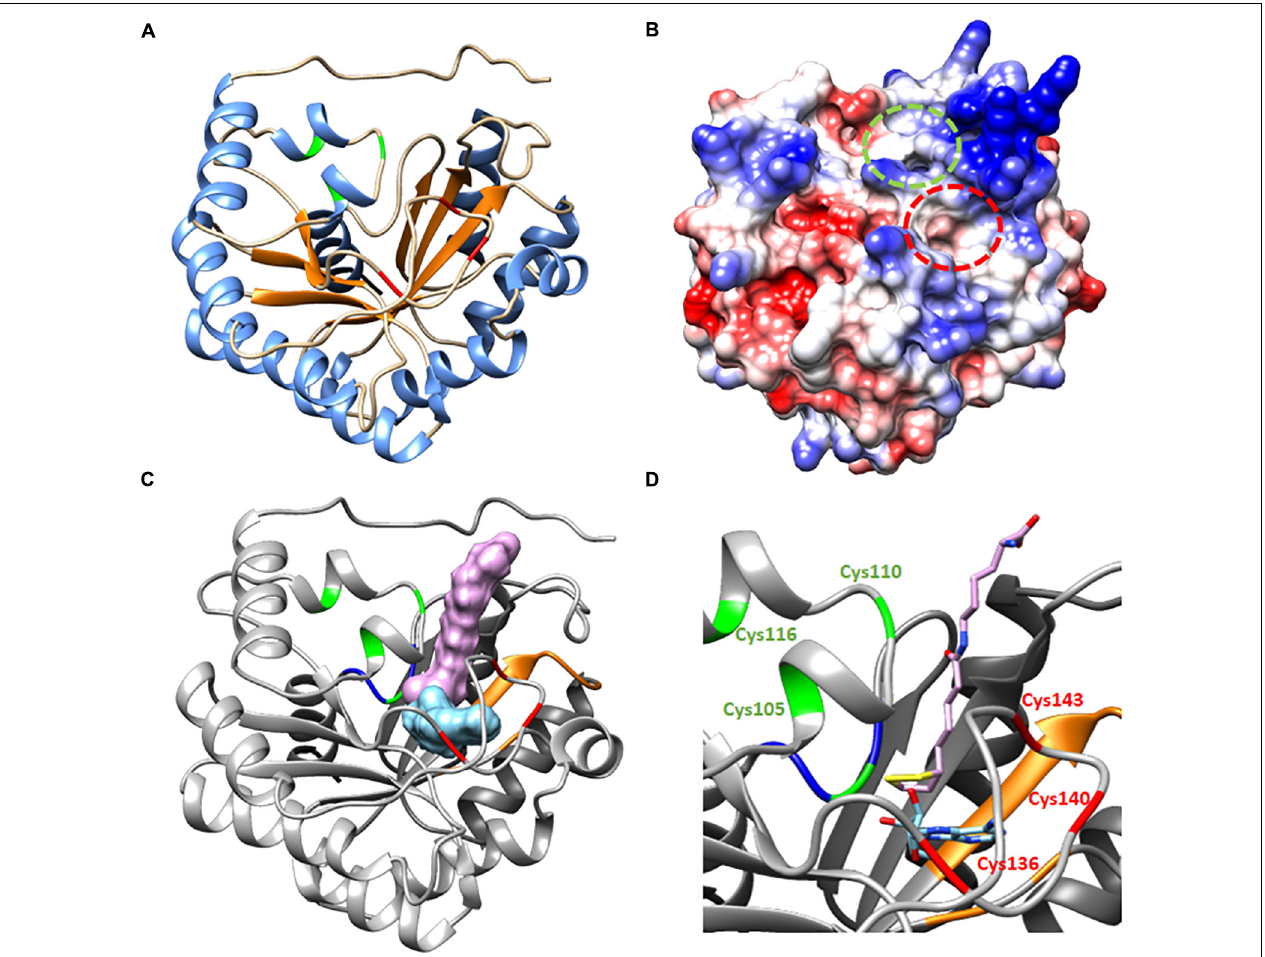
FIGURE 6 | Proposed structure and molecular docking model for Ha LIP1m. (A) TIM partial barrel structure showing the secondary structure elements, with an α helix motif are in blue and the β strands are in orange. (B) Coulombic surface coloring showing the gaps where substrates interact. Indicated in red is the gap where octanoyl-Lys is positioned to form lipoyl-Lys, while the gap where SAM interacts to form 5 (cid:48) -deoxyadenosyne radicals is in green. (C) Molecular docking. 3D Ribbon diagram with substrates (lipoyl-lys and 5 (cid:48) deoxiadenosine) located at the active site of protein. The residues involved in catalytic activity are in red (the RS cluster responsible for SAM reduction) and green (auxiliary cluster donating the sulfur atoms during LA synthesis). The Ser residue in green forms part of the R(S/T)Y motif (in blue) located close to the auxiliary cluster that allows the coordination of the cluster. The residues involved in SAM recognition are in orange and the lipoyl-lys peptide chain is positioned out of the gap with the sulfur atoms of the LA ring toward the core of the protein, close to 5 (cid:48) deoxiadenosine. (D) Amplified ribbon diagram of the active center of the protein with the